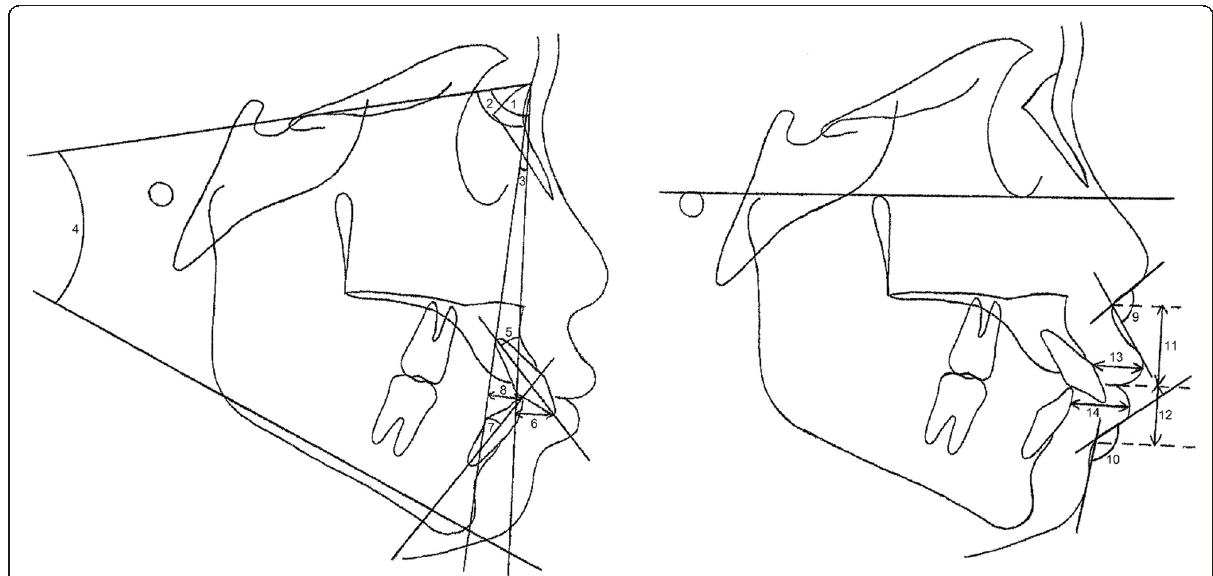
Fig. 3 Angular and linear measurements utilized for evaluation of skeletal, dental, and soft tissue morphology before treatment. 1 SNA angle, 2 SNB angle, 3 ANB angle, 4 SN-GoGn angle, 5 U1-NA (angle), 6 U1-NA (linear), 7 L1-NB (angle), 8 L1-NB (linear), 9 nasolabial angle: NLA (Cm-Sn-Ls angle), 10 labiomental angle: LMA (Li-Ils-Pg ’ angle), 11 upper lip length (Sn-Ss), 12 lower lip length (Ils-Si), 13 upper lip thickness (the labial surface of U1 to Ls), and 14 lower lip thickness (the labial surface of L1 to